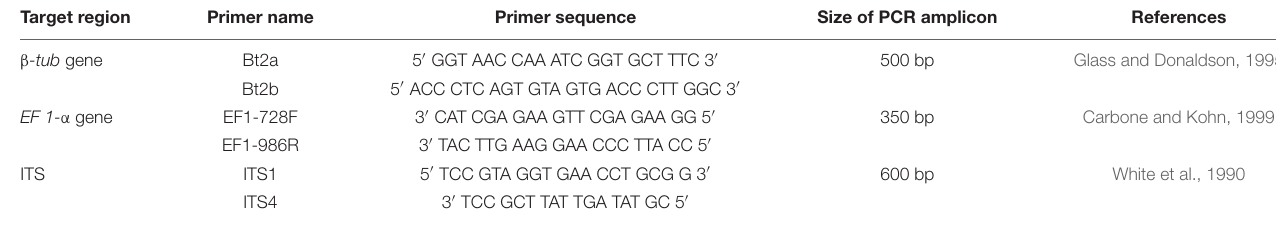
TABLE 2 | Primer sets and corresponding amplification